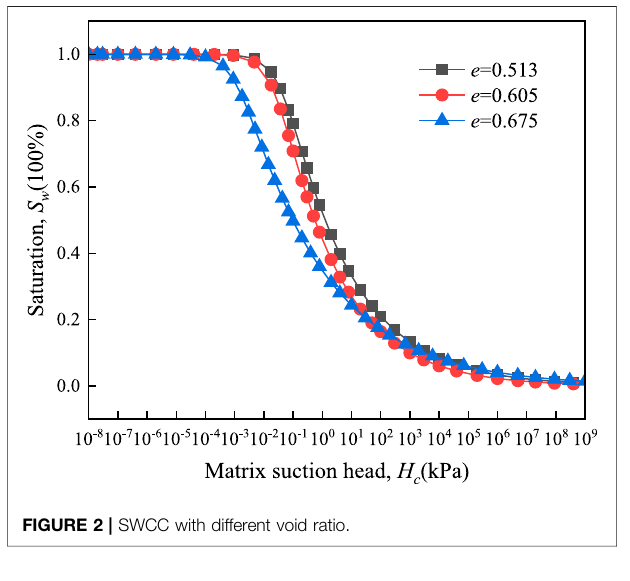
FIGURE 2 | SWCC with different void ratio.